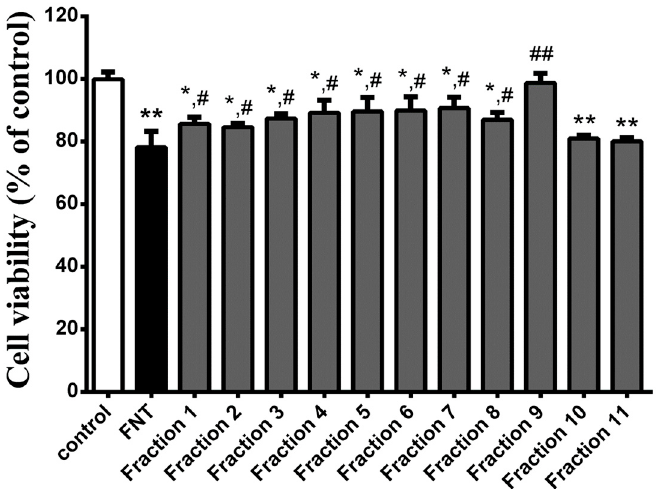
Figure 8. Effects of the 11 fractions on FNT induced immunotoxicity in splenocytes using MTT assay. Results shown are means ± SD of three separate experiments. * p < 0.05 or ** p < 0.01 vs. untreated control; # p < 0.05 or ## p < 0.01 vs. FNT treatment.